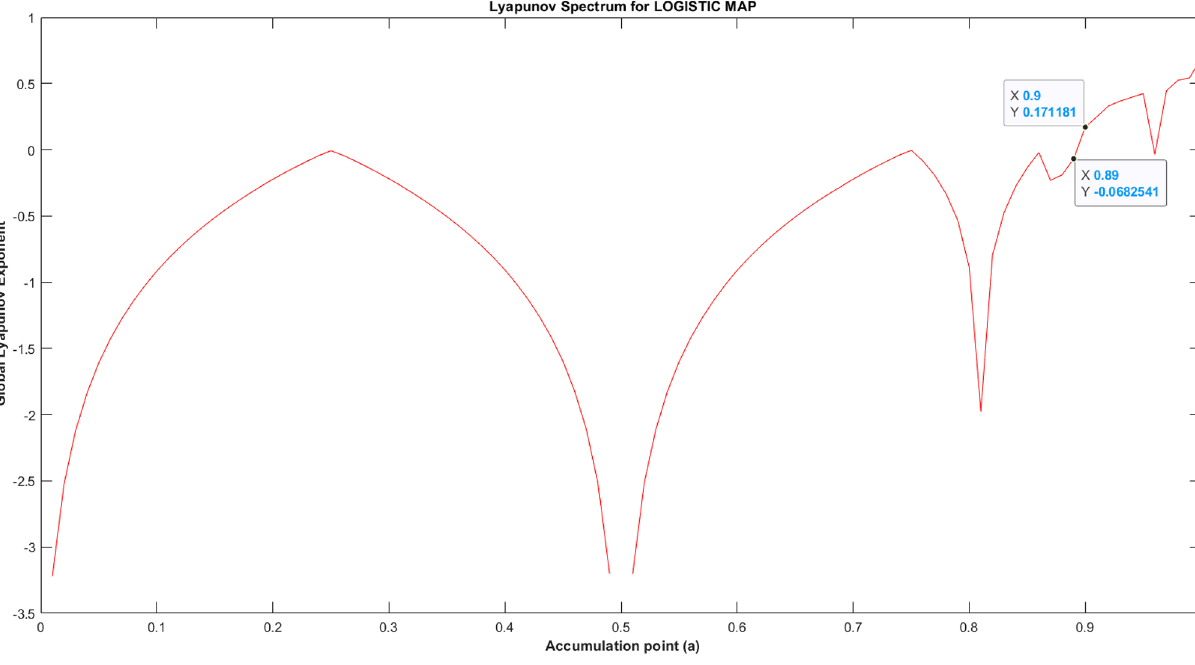
Table 1 data, that the GSM function is non-chaotic for the interval when 𝛼 is in the range [ − 0.5, 0.5 ]. To visualise the trend of accumulation points for GSM, Table 1